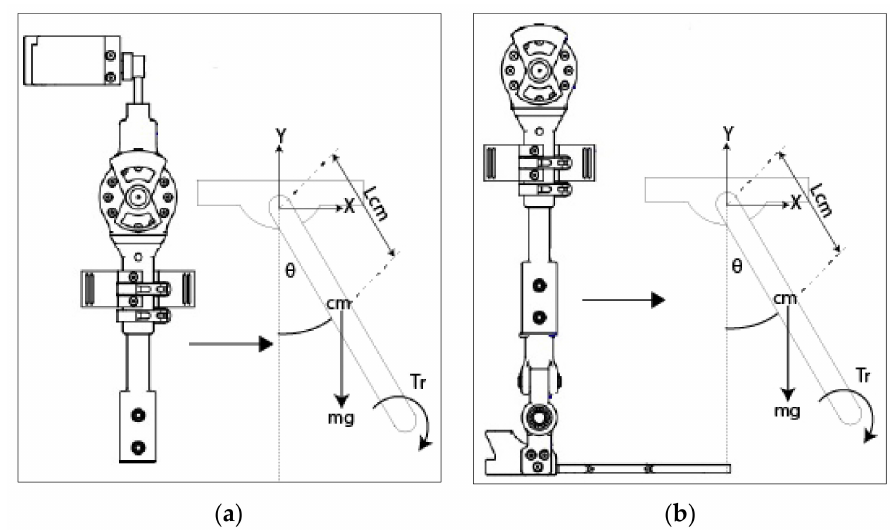
Figure 8. Diagram. ( a ) Hip Link Diagram ( b ) Knee Link